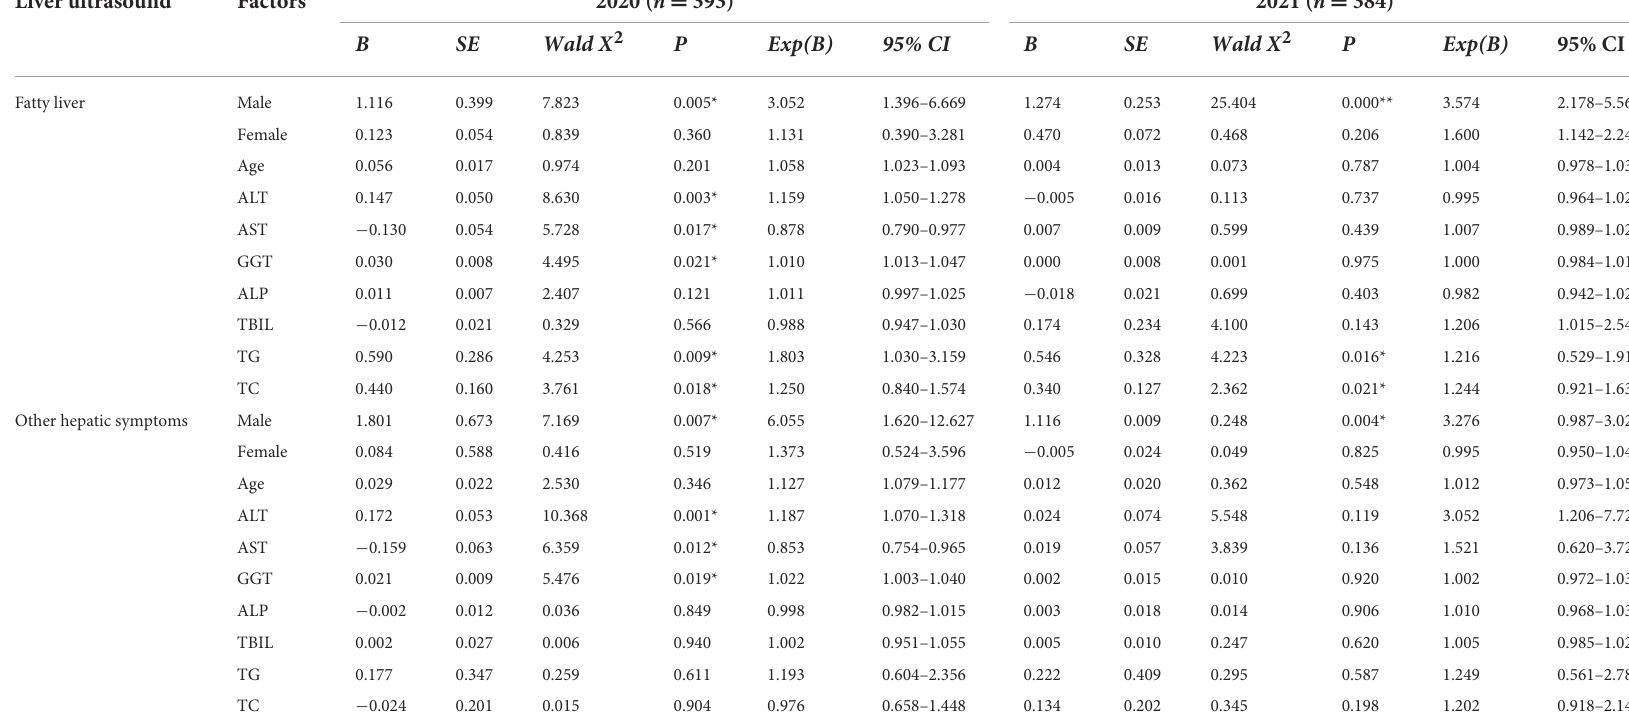
TABLE 8 Results of multiple linear regression analysis for physical exam data in Y in 2020 and